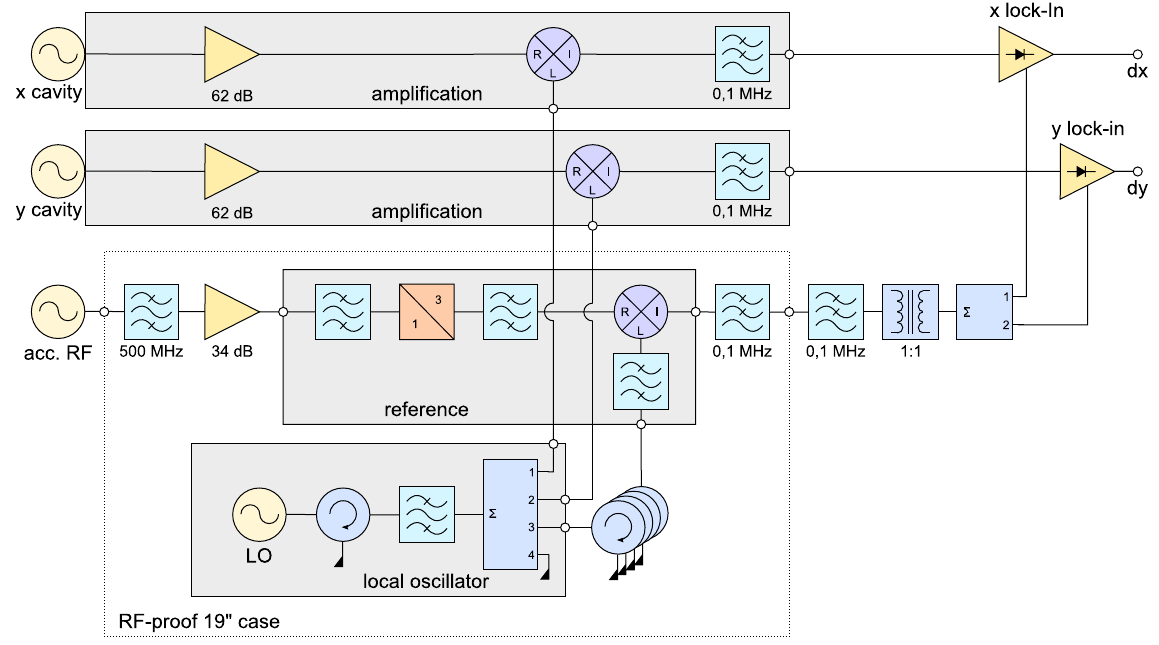
FIG. 6. Scheme of the rf signal processing. The shaded areas note functional units assembled in dedicated, well shielded rf housings. The rf, LO, and IF ports of the mixers are designated by first